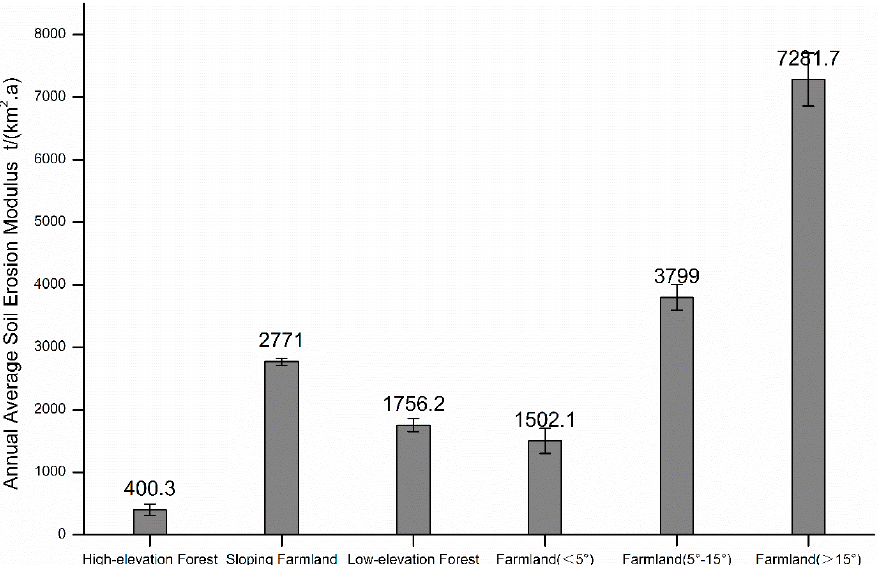
Figure 5. The soil erosion modulus under different land use types .